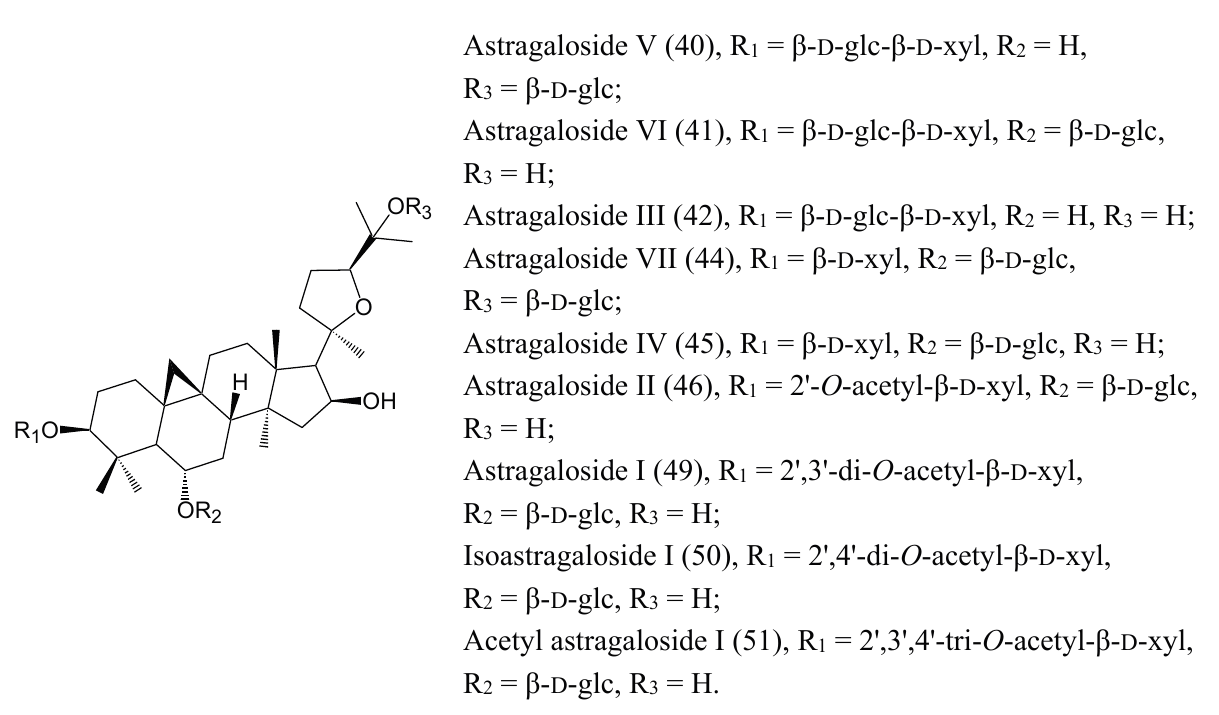
Figure 2. Chemical structures of the compounds identified in RA extract and mice